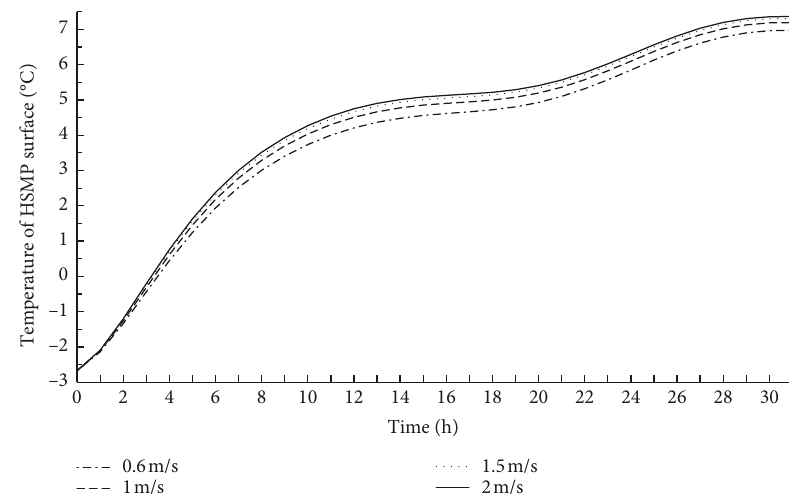
Figure 11: Temperature of the HSMP surface time-history